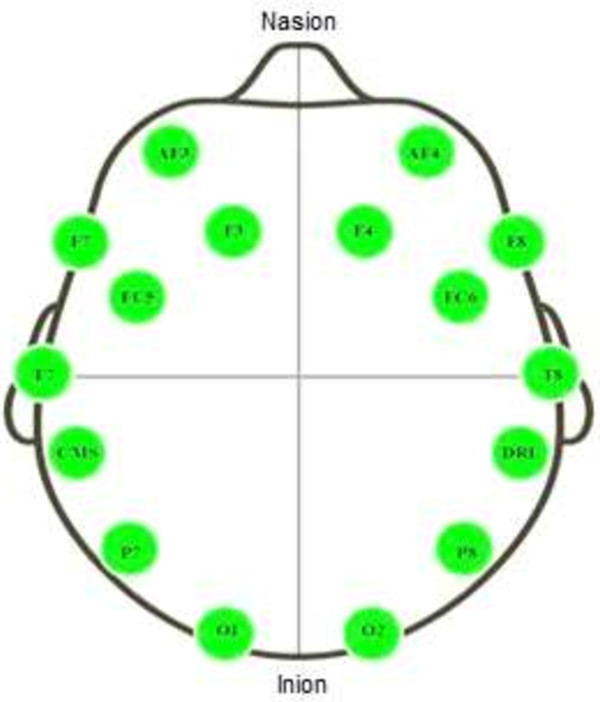
Electrode positions.